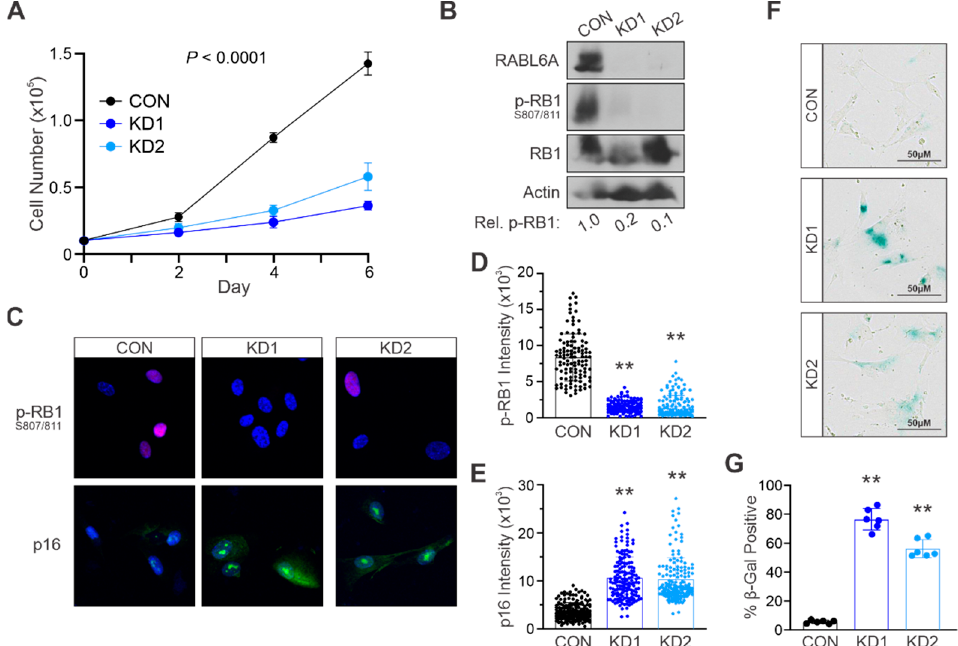
Figure 2. Loss of RABL6A causes premature stress-induced senescence in primary NHSCs. ( A ) Low passage NHSCs with control or RABL6A knockdown (KD1 and KD2) were plated at equal density and cell number counted on days 2, 4, and 6 after plating. ( B ) Representative Western blot showing effective RABL6A knockdown in KD1 and KD2 and decreased phospho-RB1 S807/811 compared to CON. Below, quantified relative p-RB1 to total RB1. ( C ) Representative phospho-RB1 S807/811 (top, red) and p16 (bottom, green) immunofluorescence images shows RABL6A depletion causes reduced phospho-RB1 S807/S811 and induction of p16 compared to control cells. Nuclei stained with DAPI. ImageJ quantification of fluorescent intensity from three or more experiments of ( D ) phospho-RB1 S807/811 and ( E ) p16. Each dot in D and E represents an individual cell nuclei. ( F ) Representative bright field images of β -galactosidase staining, showing RABL6A loss induces senescence in NHSCs. ( G ) Quantification from three or more experiments of β -galactosidase positive cells after RABL6A knockdown. ( A ) p value determined by a generalized linear model to assess the difference between the KD1 and KD2 curves compared to CON. Error bars, SD from mean. ( D , E , G ) p value, One-way ANOVA with Dunnett’s correction. (**, p < 0.001).